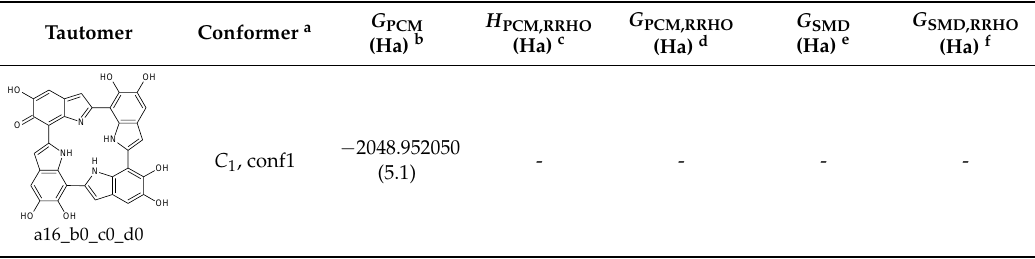
Table 8. KP-2e, neutral form in water.